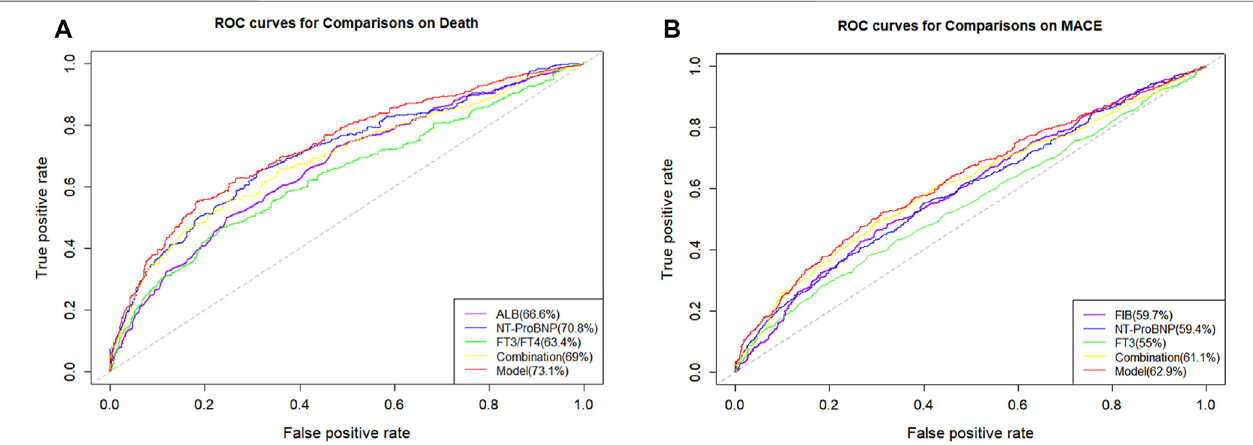
Frontiers in Molecular Biosciences |